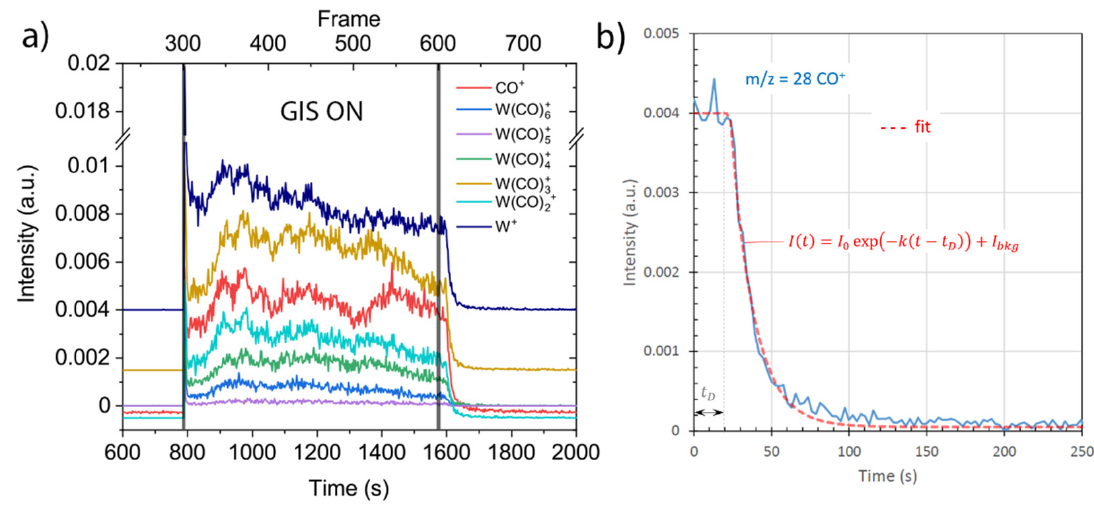
Figure 7. FEBiMS signal time evolution of selected peaks. ( a ) Time period including GIS opening, FEBID (GIS on), and GIS closing. The curves were separated on the vertical axis to increase readability of the data. ( b ) CO + intensity decay after the GIS was closed (set to t = 0). The focused electron beam was continuously irradiating at 10 kV and 30nA.